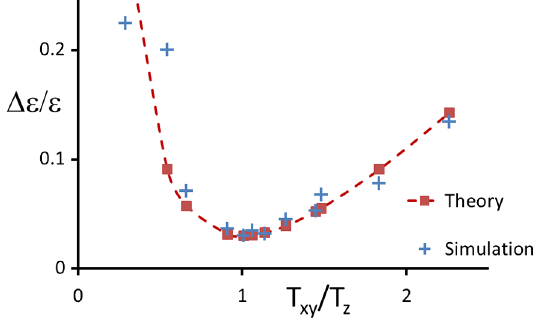
FIG. 7. Relative growth of ϵ 6 d for k 0 xyz ¼ 60 ° and varying (initial) temperature anisotropy.